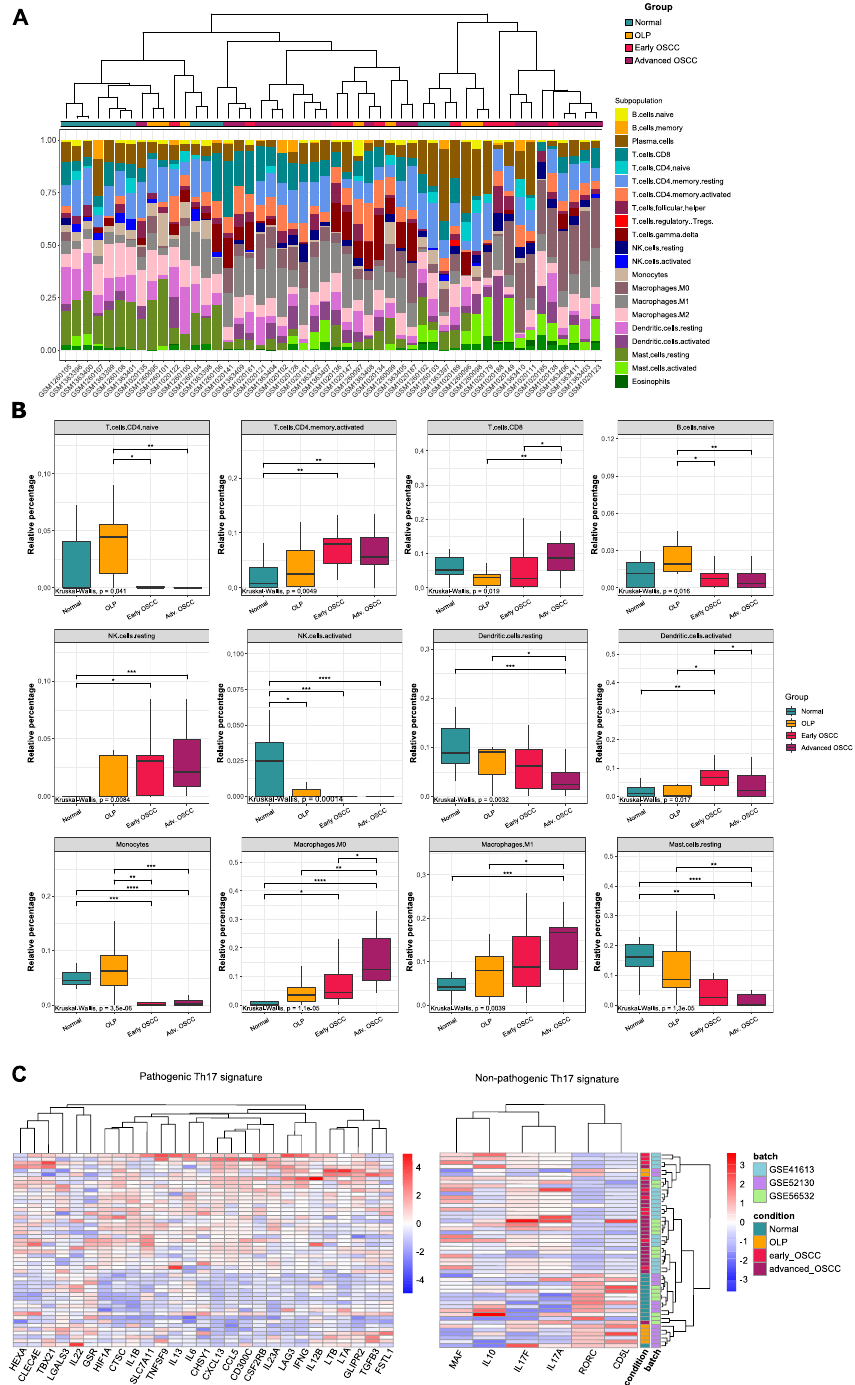
Figure 2. Proportion of cell population signatures identified using CIBERSORTx. ( A ) Stacked barplot showing cell population proportions in each sample (Oral normal mucosa, OLP, early OSCC, advanced OSCC). Dendrogram represents Ward clustering of the samples. ( B ) Relative percentage of each immune cell from oral normal mucosa, OLP, early and advanced OSCC. Comparisons among groups were made using the Kruskal– Wallis test followed by Dunn’s post-hoc test, with p-values lower than 0.05 considered significant for both tests. *p < 0.05; **p < 0.01; ***p < 0.001; ****p < 0.0001. ( C ) Clustered heatmap of Th17-related genes. Genes were separated based on non-pathogenic and pathogenic Th17 phenotype-related expression